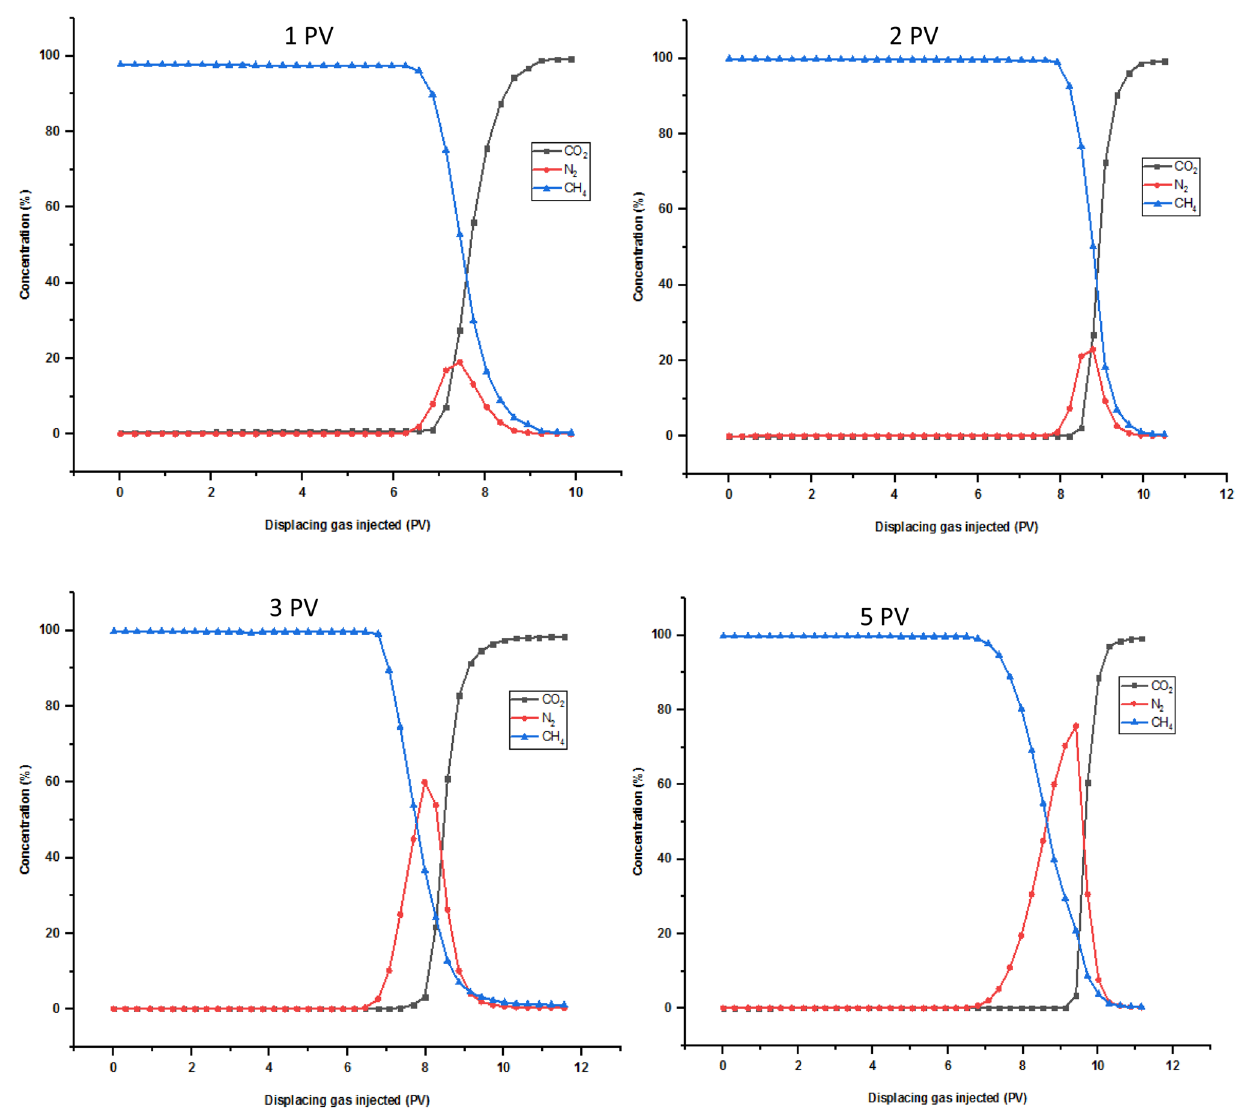
Fig. 11 Effluents concentration profiles with 1, 2, 3, and 5 PV cushion